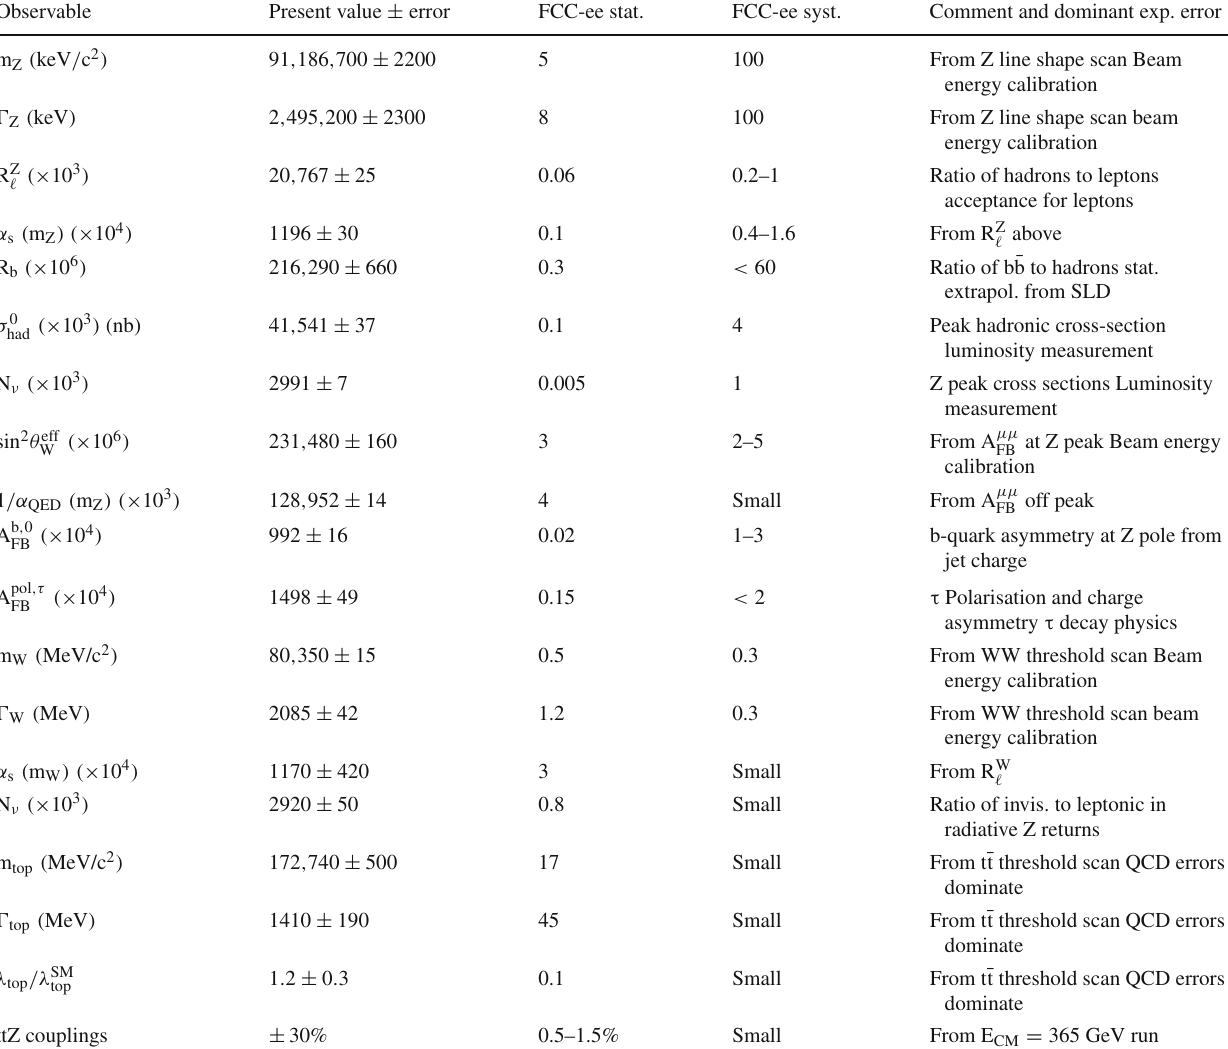
Table S.3 Measurement of selected electroweak quantities at the FCC- ee, compared with the present precision. The systematic uncertainties are present estimates and might improve with further examination. This set of measurements, together with those of the Higgs proper-